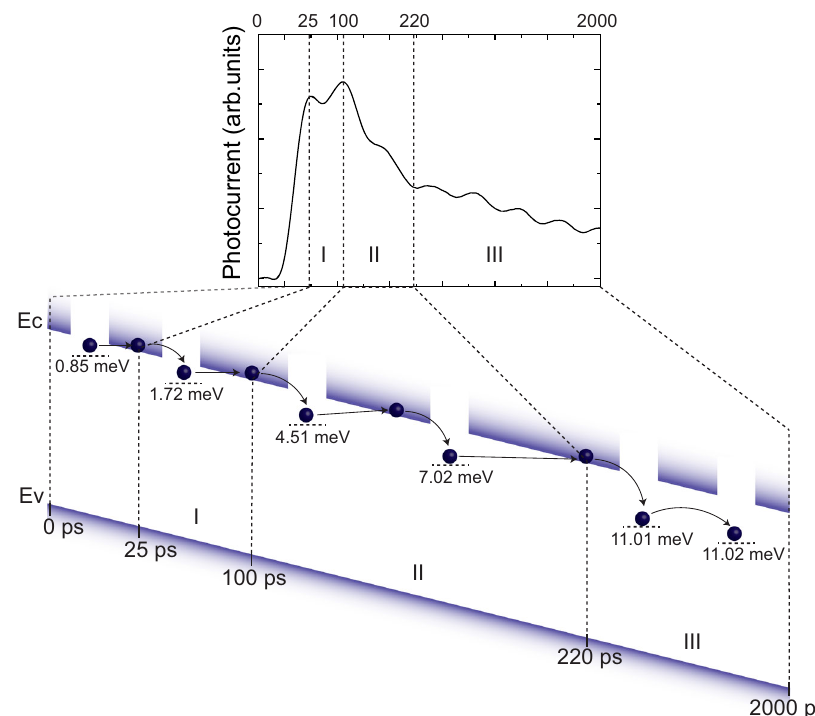
Fig. 3 The schematic of phonon-assisted tunneling and hopping transport dynamics. Charge carriers that initially fall into ultra-shallow trap states are; (I) de-trapped on to the conduction band ( E c ) via tunneling before slowly recombining, (II) relax into slightly deeper ultra-shallow states and de-trapped again, (III) “ hop ” between shallow trap states. Only electron motion is demonstrated in the model since holes follow the same mechanism. The zero-time point is set at 10% of maximum photocurrent. Note: to clarify the transport process and for convenience only some of the typical states existing within each region are shown. Whereas in the actual case trap levels in the regions between 0 and 2000ps are continuous as seen in Fig. 2. The valance band is depicted by E v